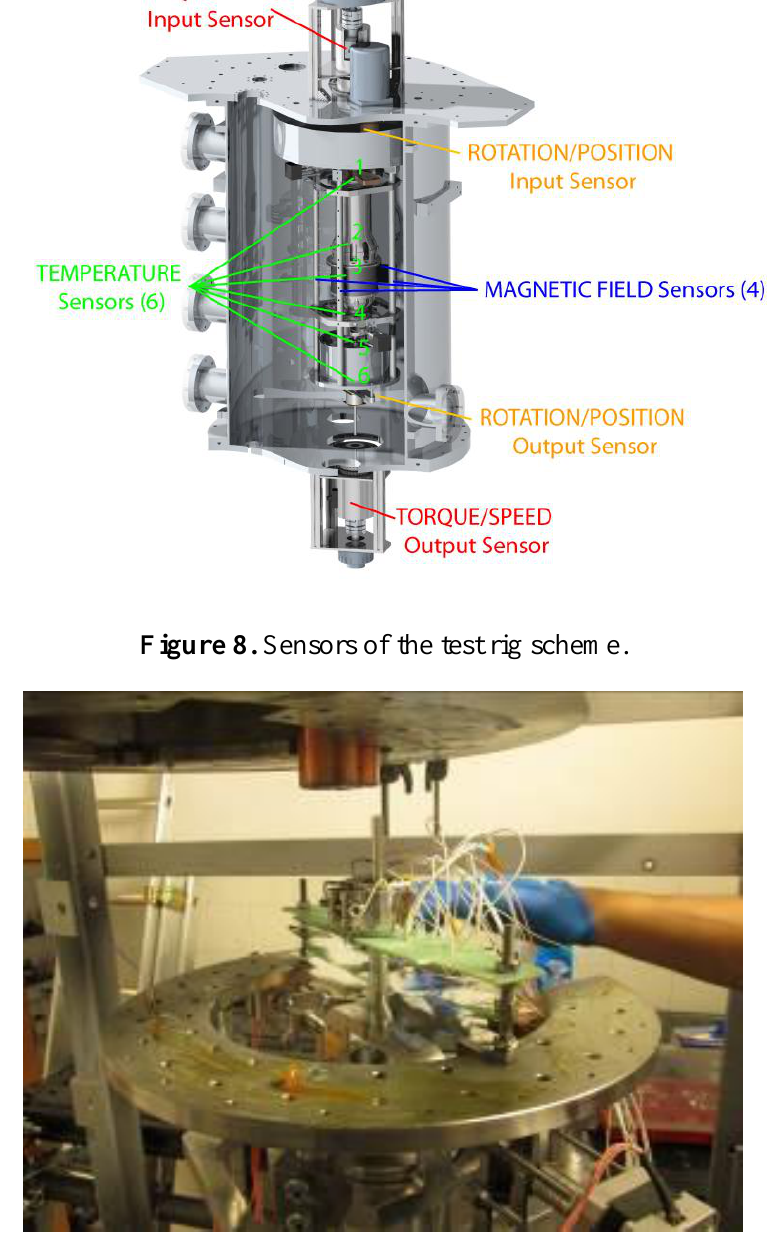
Figure 9. Rotation and position contactless sensor for the floating